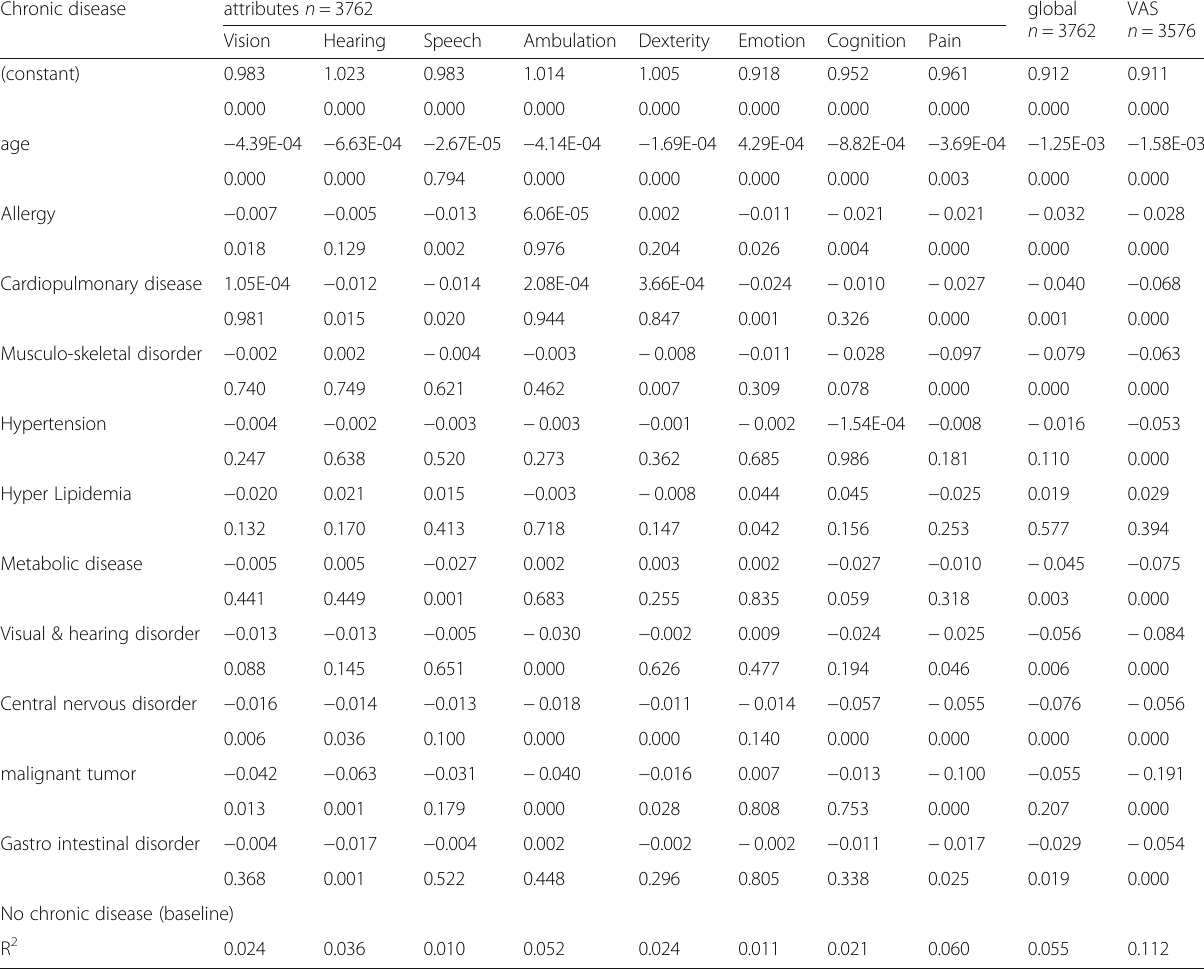
Table 8 Linear regression estimates for model of utility score (single attribute, multiattribute global HUI3) and VAS score as a function of age and type of chronic disease Chronic